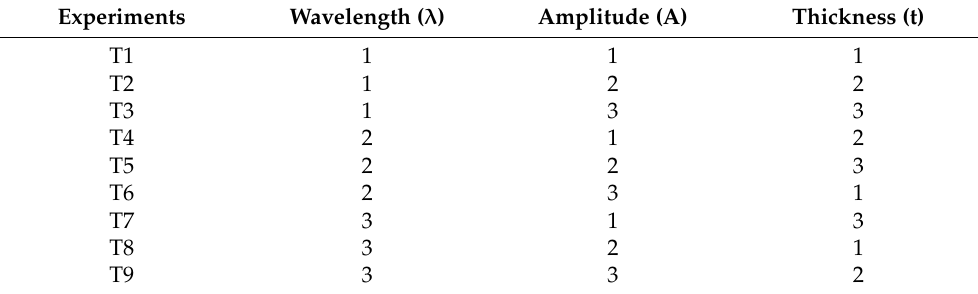
Table 2. L 9 orthogonal